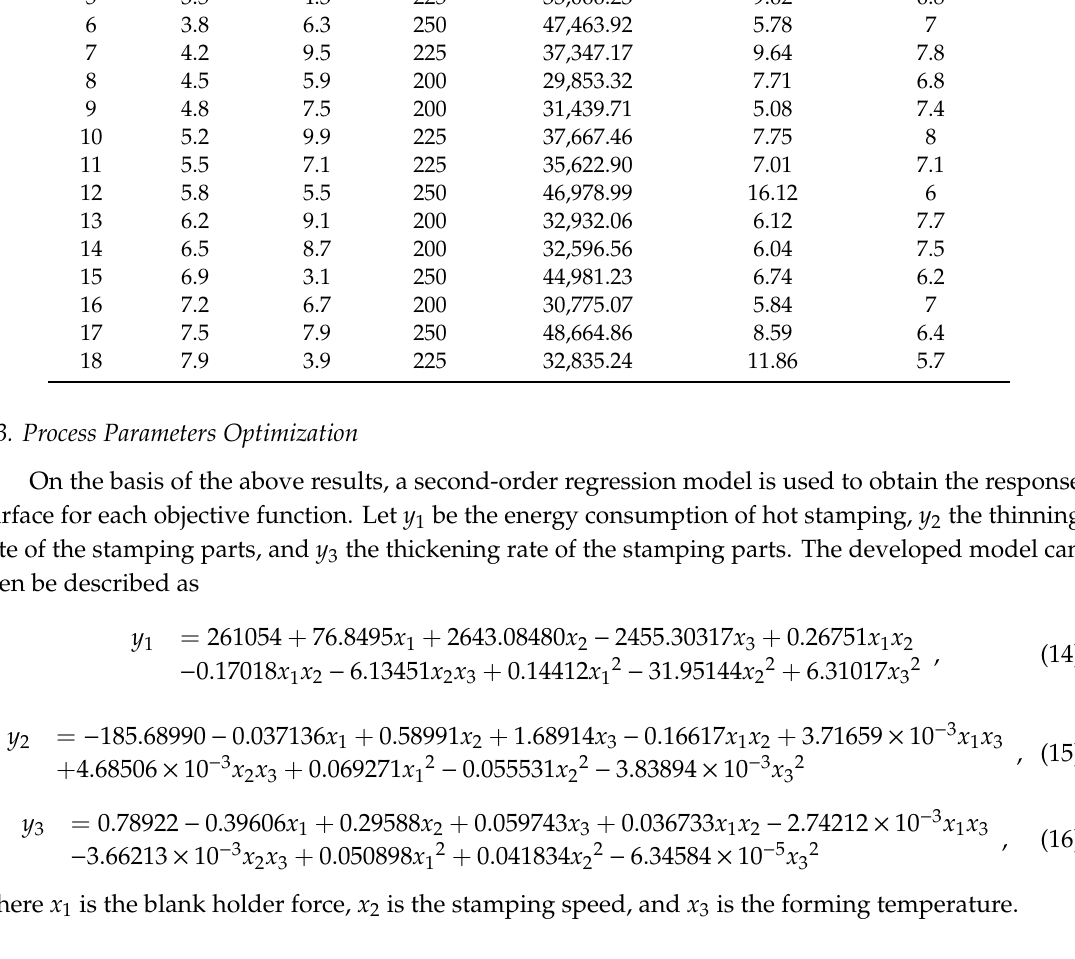
Table 3. Experimental design points and corresponding results.